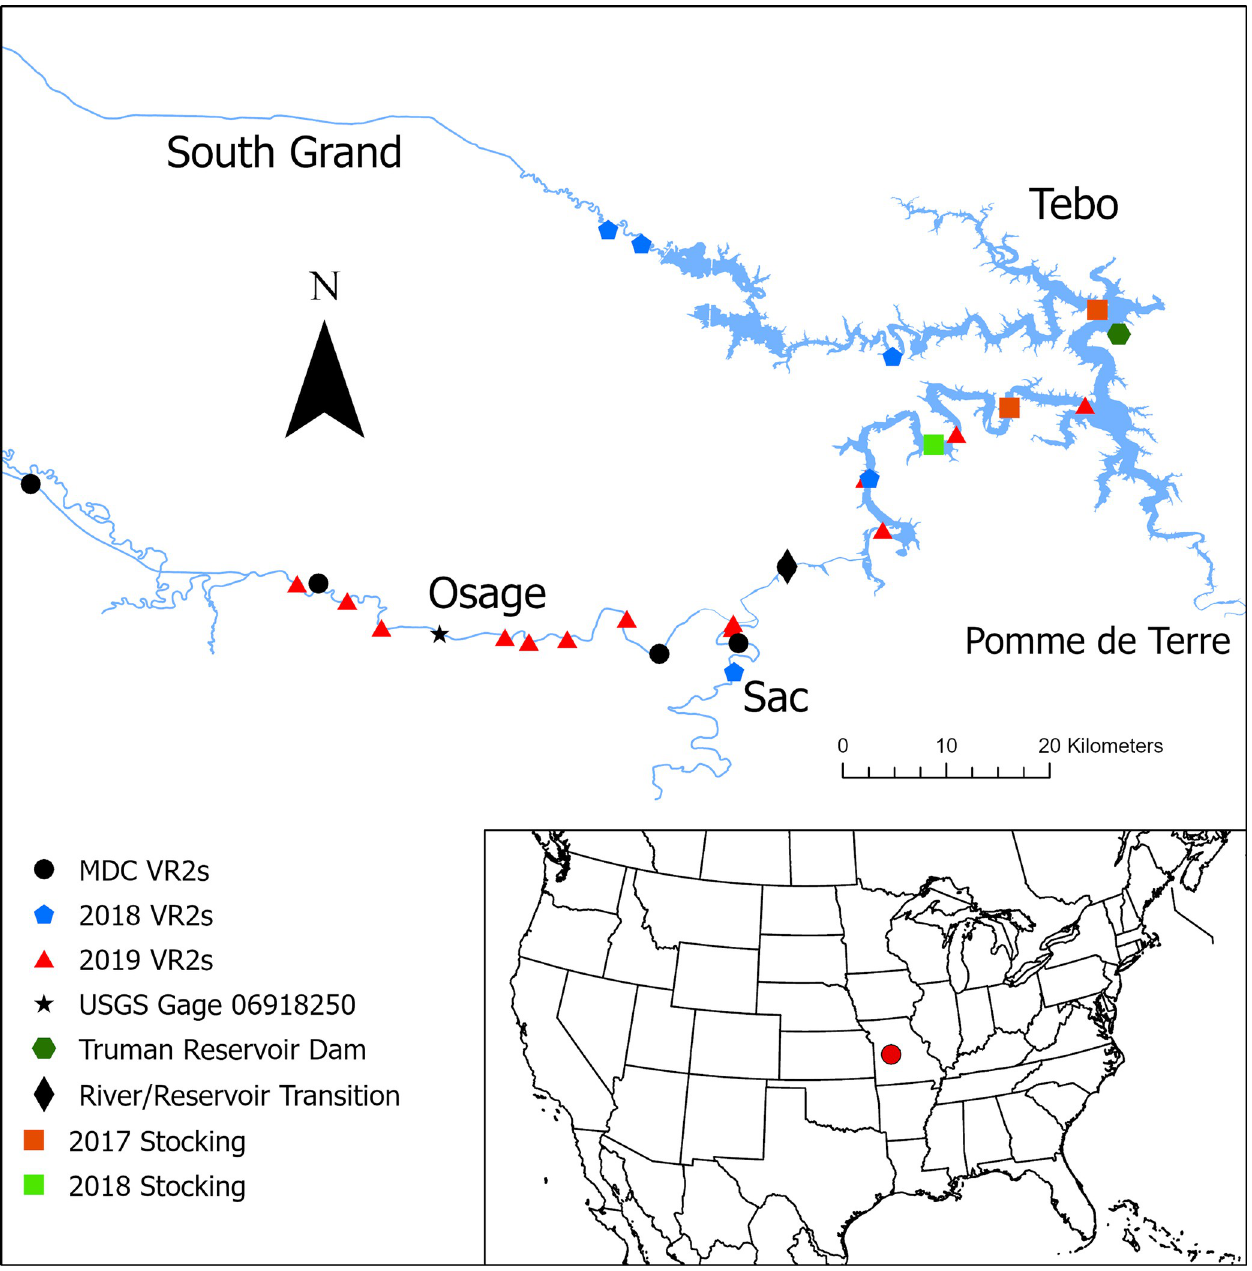
Fig 1. Location of tagged grass carp Ctenopharyngodon idella stockings and of 18 stationary acoustic receivers (VR2s) deployed while tracking them on Truman Reservoir, Missouri in 2018 and 2019. Receivers were located on the Osage River, Sac River, South Grand River, and Tebo Creek. Five